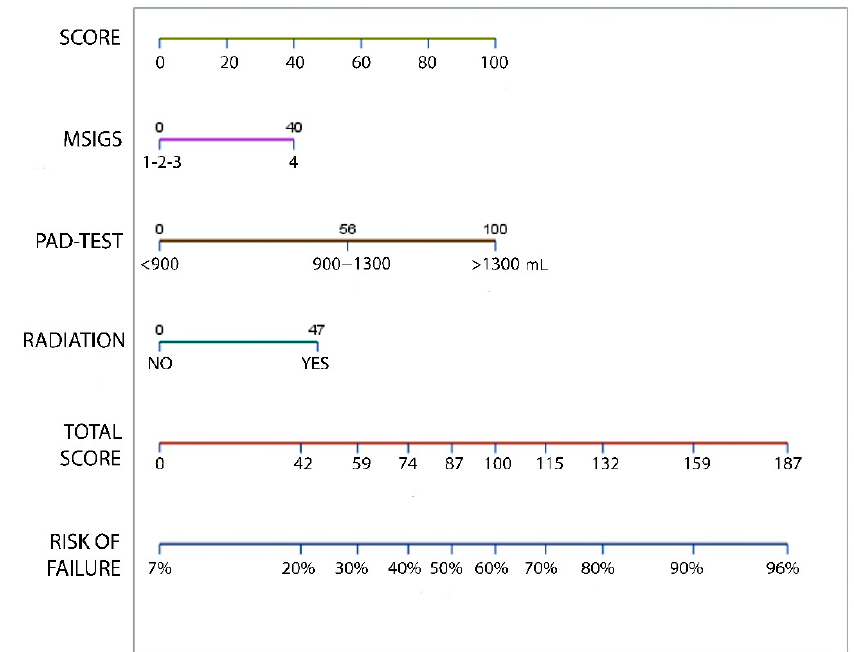
Figure 4. Distribution of 24-h pad-test by MSIGS (Spearman’s ρ = 0.76; p < 0.0001).